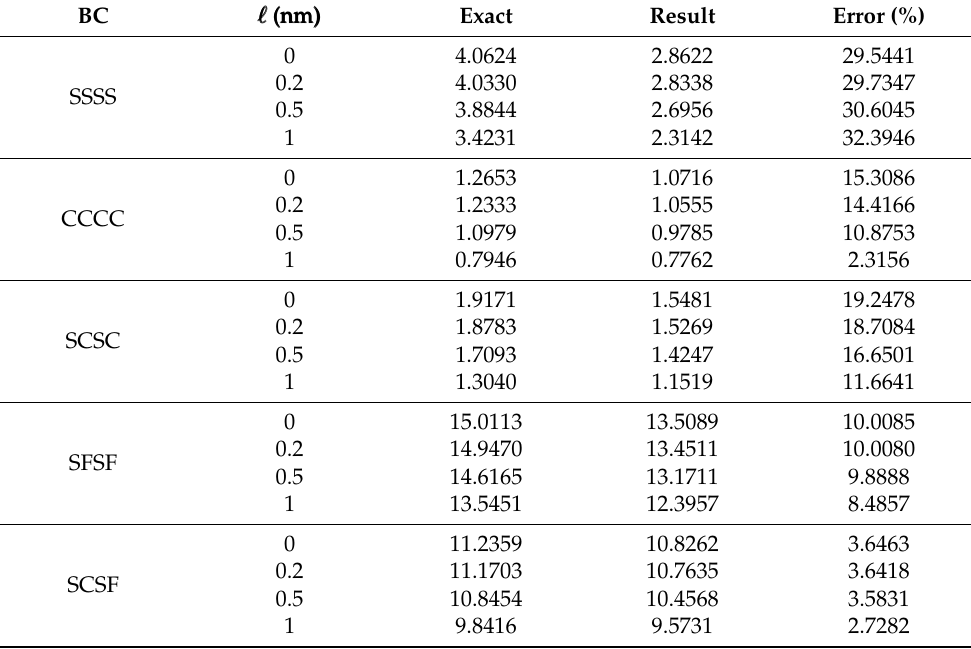
Table 3. Values of ¯ w for 3 × 3 nodal distribution, obtained for α C = 3, q = 1.3, α s = 2.